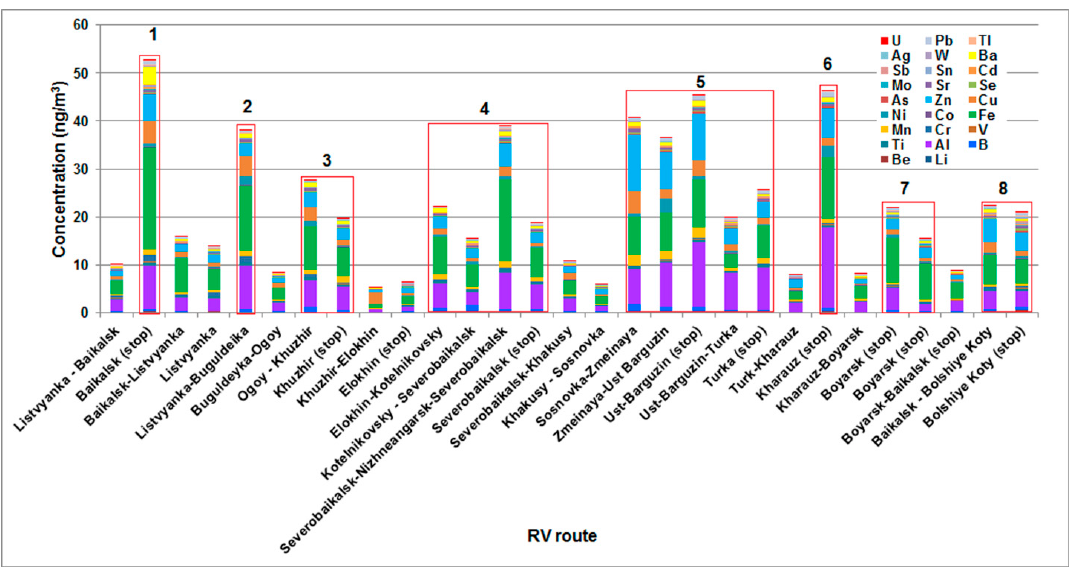
Figure 7. Variability of the elemental composition in the aerosol of the near-water atmospheric layer above Lake Baikal along the route of the RV «Akademik V.A. Koptyug» from 24 July to 4 August 2019, ng/m 3 .